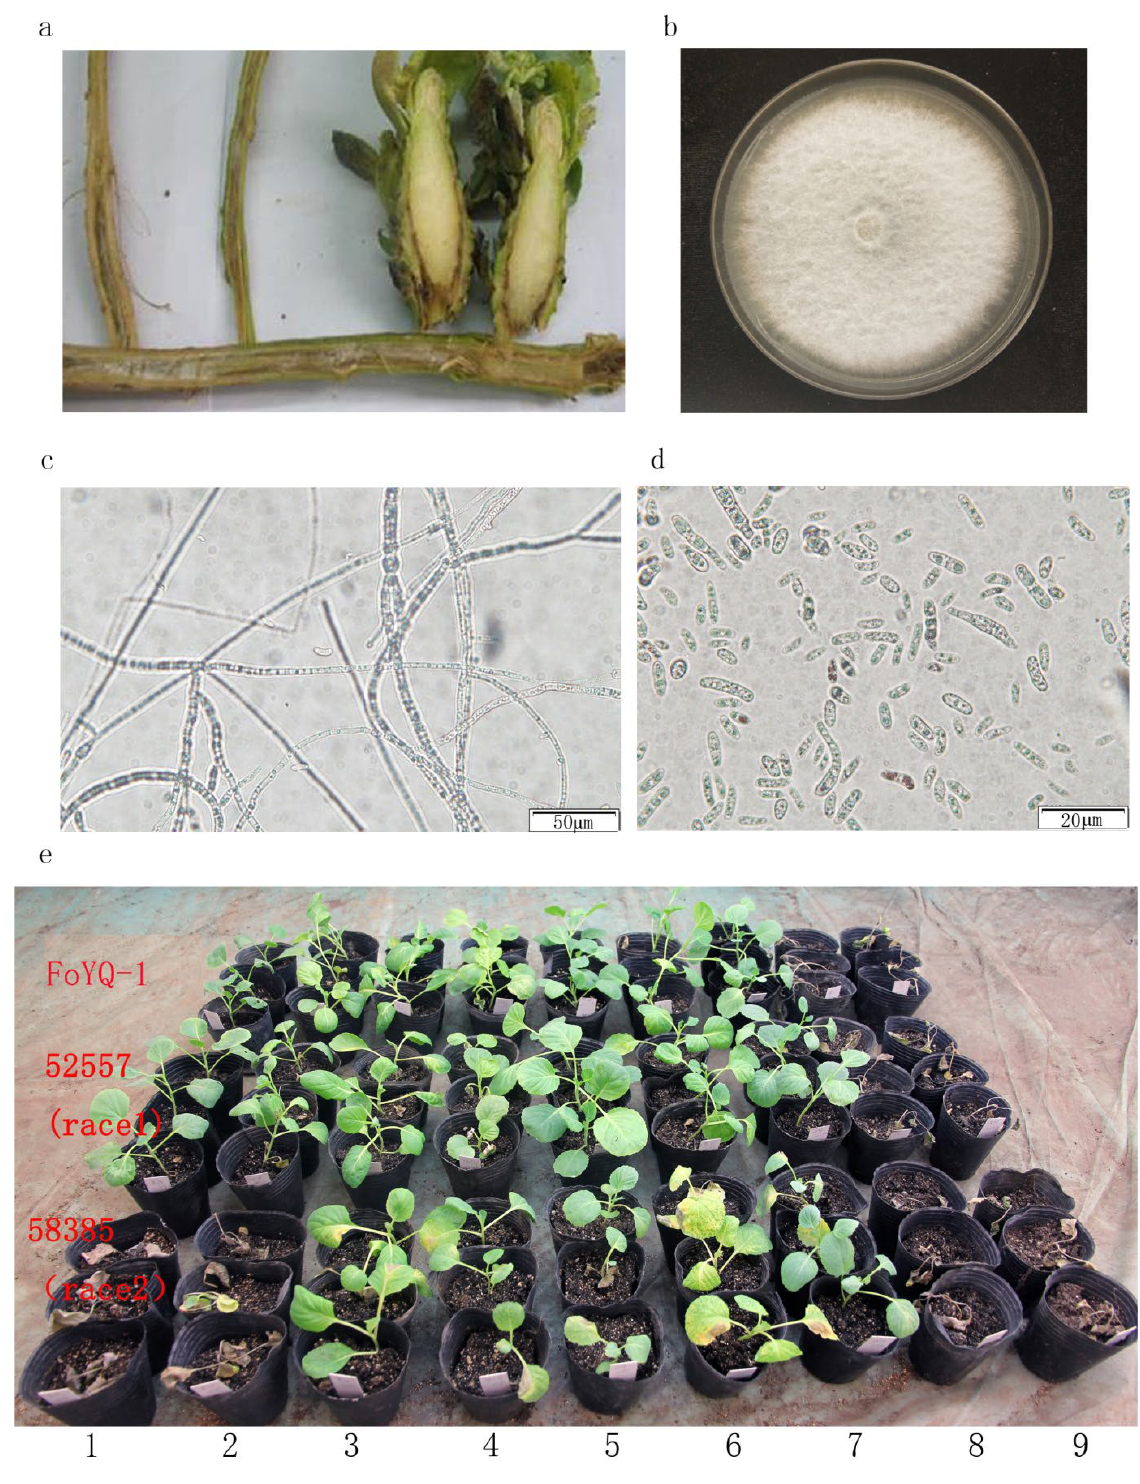
Figure 1. Morphological identification of FOC1 isolates from diseased plants. ( a ) The diseased cabbage plants show typical symptoms of fusarium wilt including stunts, wilts, and vascular ne- crosis; ( b ) observed colony morphology of FOC1 isolates; ( c , d ) microscopic observation on mycelia and conidia of FOC1 isolates; ( e ) different cabbage cultivars were used to FoYQ-1 pathogenicity and race tests. FOC1 race1 (52,557) and FOC race2 (58,385) were used as race test control. The upper two lines were FoYQ-1 pathogenicity test, and the middle two lines and the lower two lines were 52,557 and 58,385 pathogenicity test, respectively. 1 Cultivar “Xiaqiang” was resistant (R) to FOC1 but susceptible (S) to FOC2. 2 Cultivar “Zhonggan18” was R to FOC1 but S to FOC2. 3 Cultivar